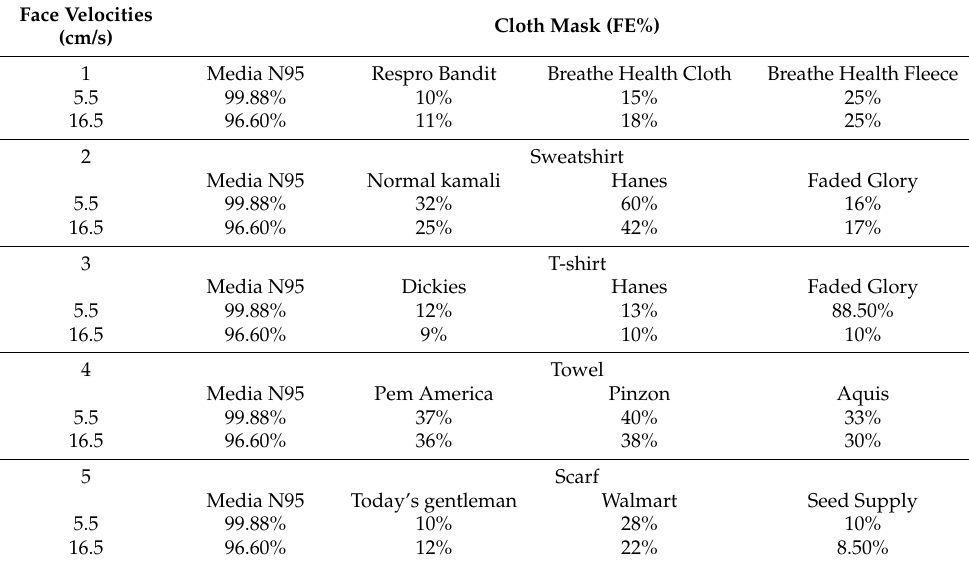
Table 3. The results for the filtration efficiency of five kinds of common fabrics with varied face velocities